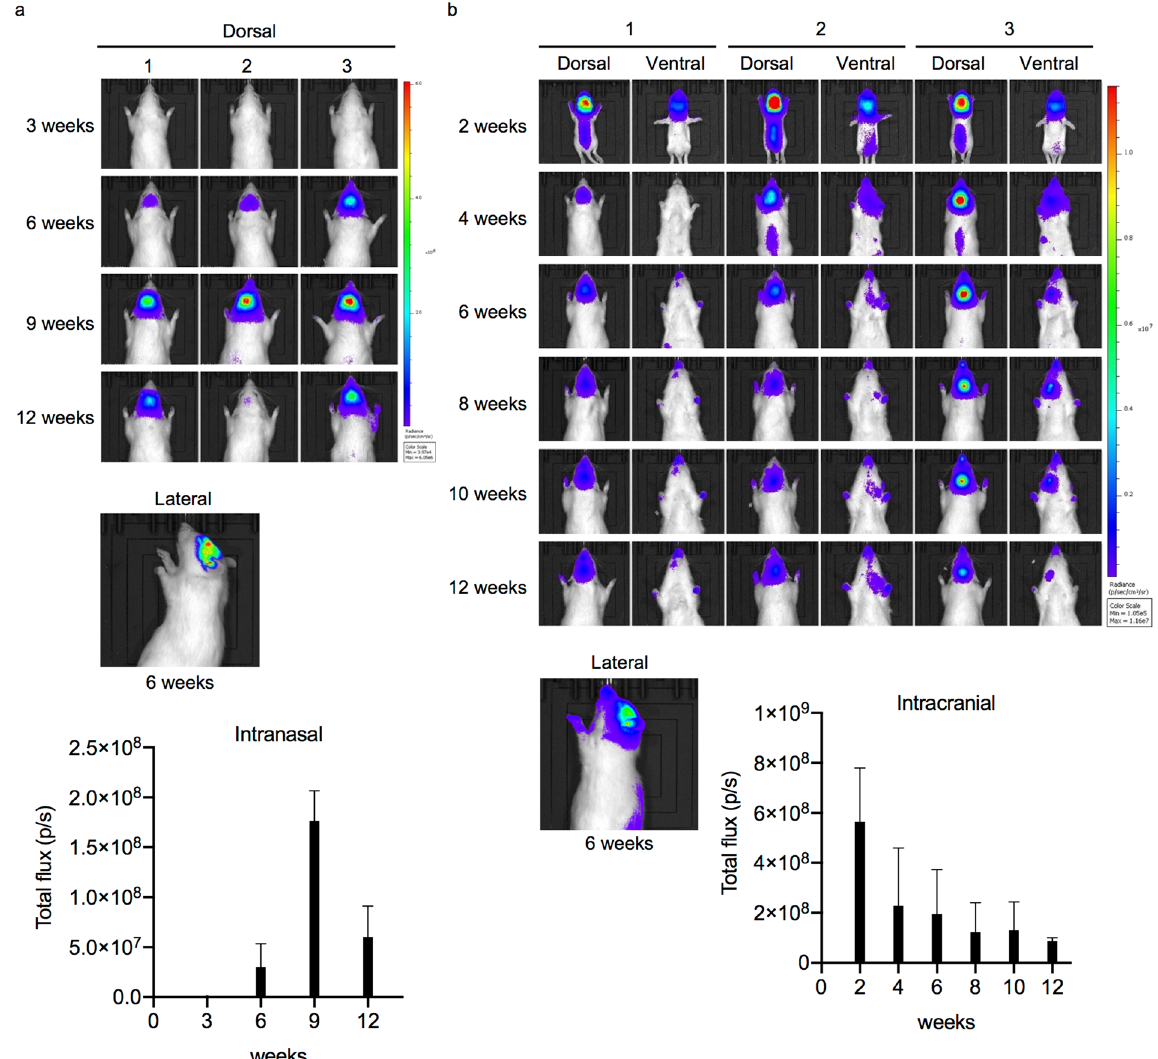
Figure 1. In vivo imaging of REVec. ( a ) In vivo luciferase activity of Lewis rats at 3, 6, 9, and 12 weeks after IN administration of 10 4 FFU REVec-Luciferase. Dorsal and lateral images are shown at indicated time points. Total flux rate at each time point (photons/sec) is shown below. (n = 3). ( b ) In vivo luciferase activity of Lewis rats after IC administration of 10 4 FFU REVec-Luciferase. Luciferase activity was measured as above at 2, 4, 6, 8, 10, and 12 weeks post-administration. Dorsal, ventral, and lateral images are shown at indicated time points. Total flux rate at each time point (photons/sec) is shown below (n =